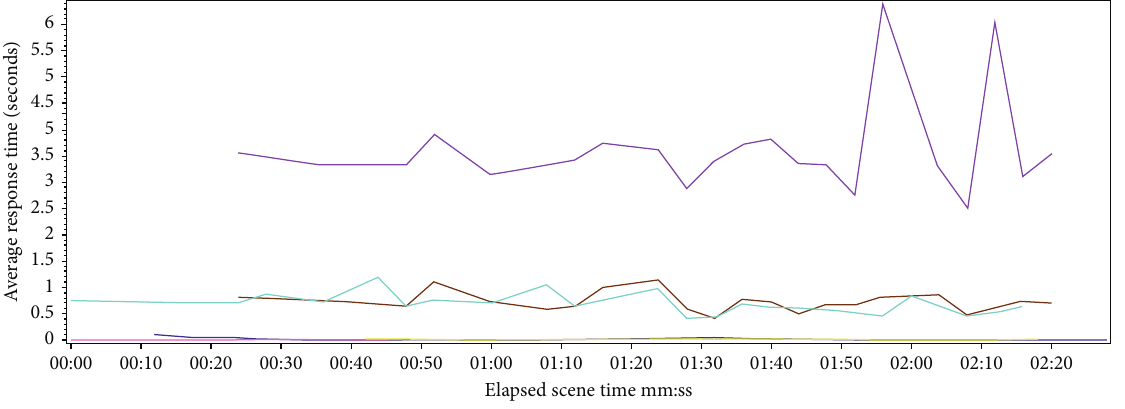
Figure 1: Average transaction response time for 10 concurrent transactions.